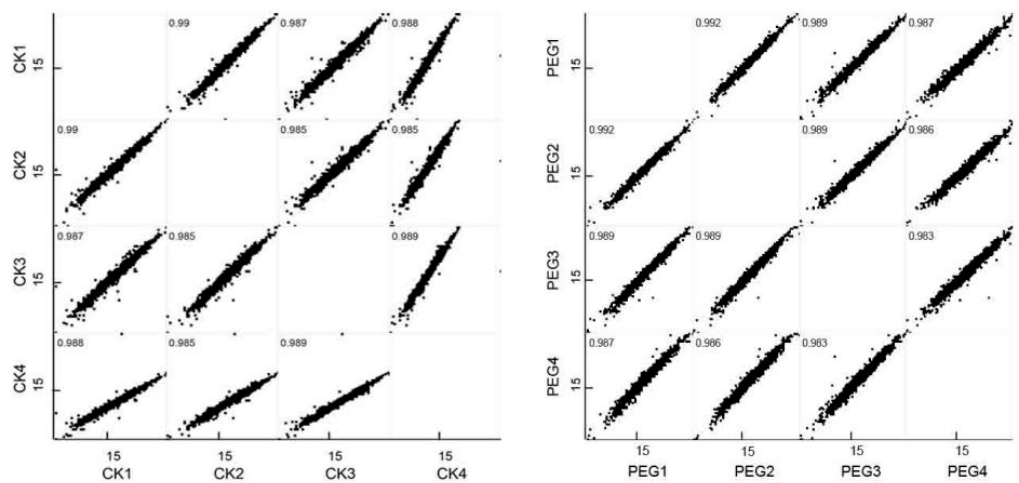
Figure 2. Correlations of replicates of wheat leaves under drought stress and well-watered condition.